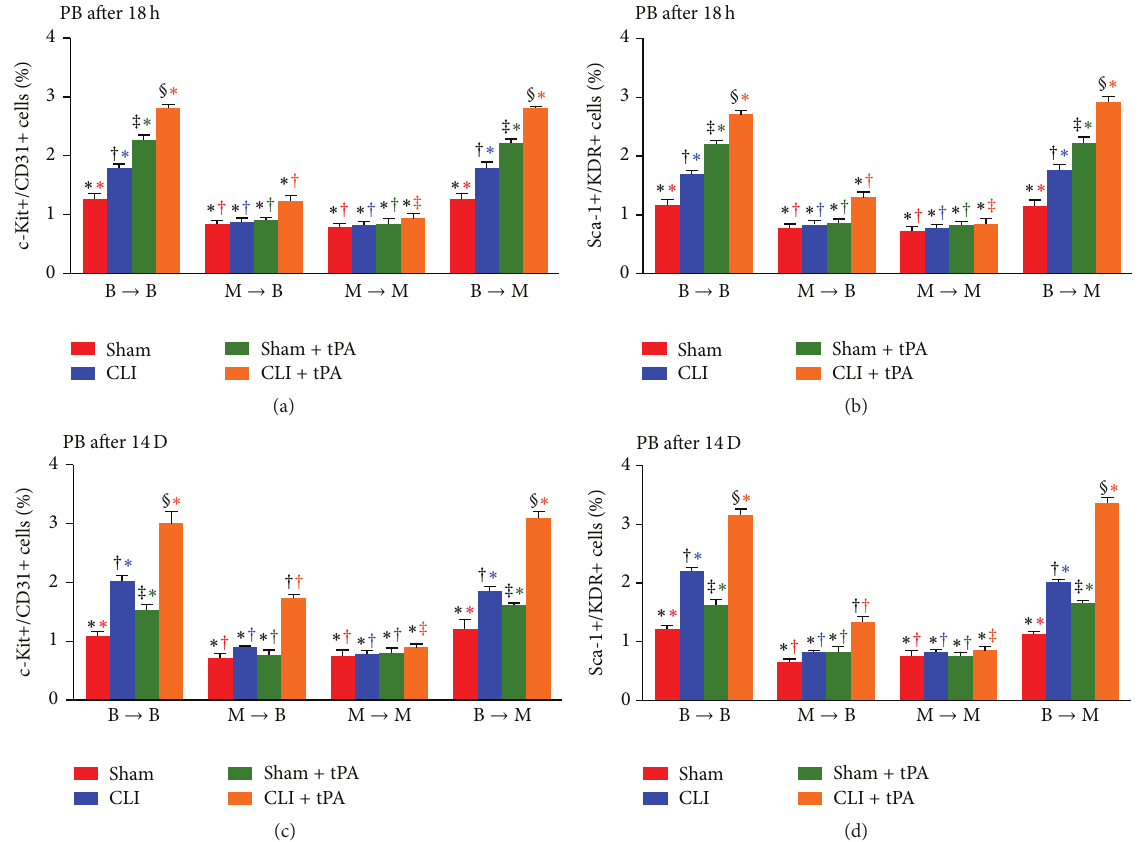
Figure 2: Flow cytometric analysis of circulating level of endothelial progenitor cells (EPCs) at 18h and on day 14 after critical limb ischemia (CLI) procedure. (Upper panel) Circulating numbers of c-Kit+/CD31+ cells (a) and Sca-1+/KDR+ (b) at 18h after CLI procedure. 𝑛 = 4 for each group. (Lower panel) Circulating numbers of c-Kit+/CD31+ cells (c) and Sca-1+/KDR+ cells (d) at day 14 after CLI procedure. 𝑛 = 6 for each group. All statistical analyses were performed by one-way ANOVA followed by Bonferroni multiple comparison post hoc test. tPA = tissue plasminogen activator. (1) Statistical analysis for subgroups [i.e., sham control (SC), CLI, SC + tPA, and CLI + tPA] of each group [group 1 (WT to WT, i.e., B → B), group 2 (MMP-9 −/− to WT, i.e., M → B), group 3 (MMP-9 −/− to MMP-9 −/− , i.e., M → M), group 4 (WT to MMP-9 −/− , i.e., B → M)]. For subgroups with different black symbols ( ∗ , † , ‡ , and §), 𝑝 < 0.05 . (2) Statistical analysis for group comparison with respective treatment condition (comparing among bar charts with the same color). (1) For SC subgroup (red bar chart), groups with different red symbols ( ∗ , † ), 𝑝 < 0.05 . (2) For CLI subgroup (blue bar chart), groups with different blue symbols ( ∗ , † ), 𝑝 < 0.05 . (3) For SC + tPA subgroup (green bar chart), groups with different green symbols ( ∗ , † ), 𝑝 < 0.05 . (4) For CLI + tPA subgroups (orange bar chart), groups with different orange symbols ( ∗ , † , and ‡ ), 𝑝 < 0.05